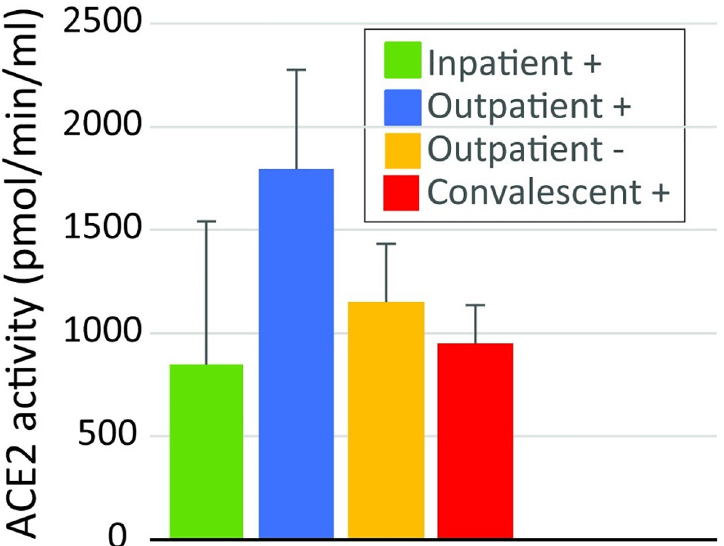
Fig 4. Activity of soluble ACE2 protein in plasma of patients that had ACE2 antibodies in plasma compared to those that did not. Activity of the enzyme in plasma was decreased in patients that had an ACE2 antibody present. Bars show mean values and error bars show standard error of the mean ( �� p < 0.01). The group labeled + had ACE2 antibodies and the group labeled–did not have ACE2